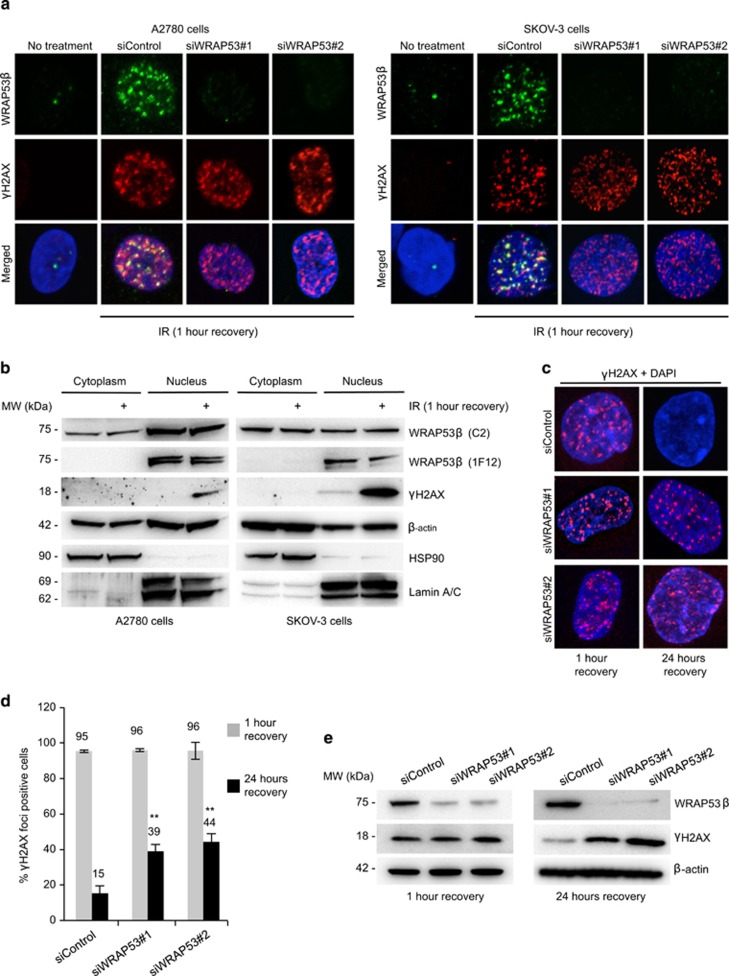
WRAP53β accumulates at the sites of DNA damage and promotes DNA repair in the ovarian cancer cell lines A2780 and SKOV-3. (a) A2780 and SKOV-3 cells were treated with siControl or two different WRAP53β-targeting oligonucleotides (siWRAP53#1 and siWRAP53#2) for 48 h, irradiated (6 Gy, 1-h recovery), fixed after preextraction with CSK buffer and immunostained for WRAP53β and γH2AX. (b) Western blot analysis of cytoplasmic and nuclear fractions from untreated or irradiated (6 Gy, 1-h recovery) A2780 and SKOV-3 cells. In all fractions HSP90 and lamin A/C were used as cytoplasmic and nuclear markers, respectively. (c) A2780 cells were treated with the same siRNAs as in (a) for 24 h; exposed to 6 Gy IR, fixed for 1 h or for 24 h later and immunostained for γH2AX. (d) Quantification of the results in (c), showing the percentage of nuclei containing >10 γH2AX foci (n=200). The error bars depict the S.E.M.; n=3, **P<0.01, as determined by Student's t-test. (e) A2780 cells were treated as in (c) and then subjected to western blotting for WRAP53β, γH2AX and β-actin